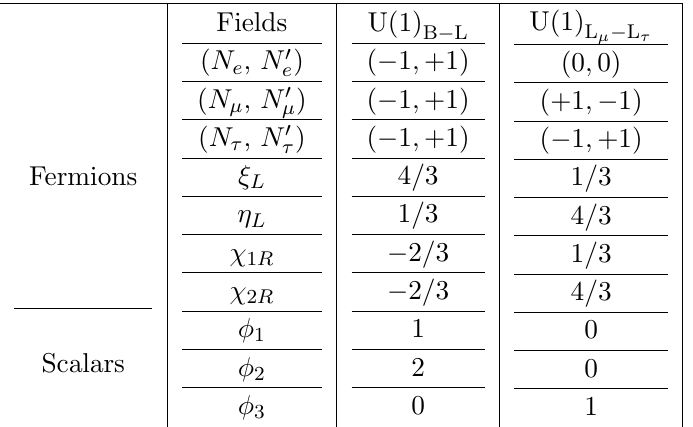
and U(1) gauge B (cid:0) L L (cid:22) (cid:0) L (cid:28) SU(2) L U(1) Y (cid:2) (cid:2)